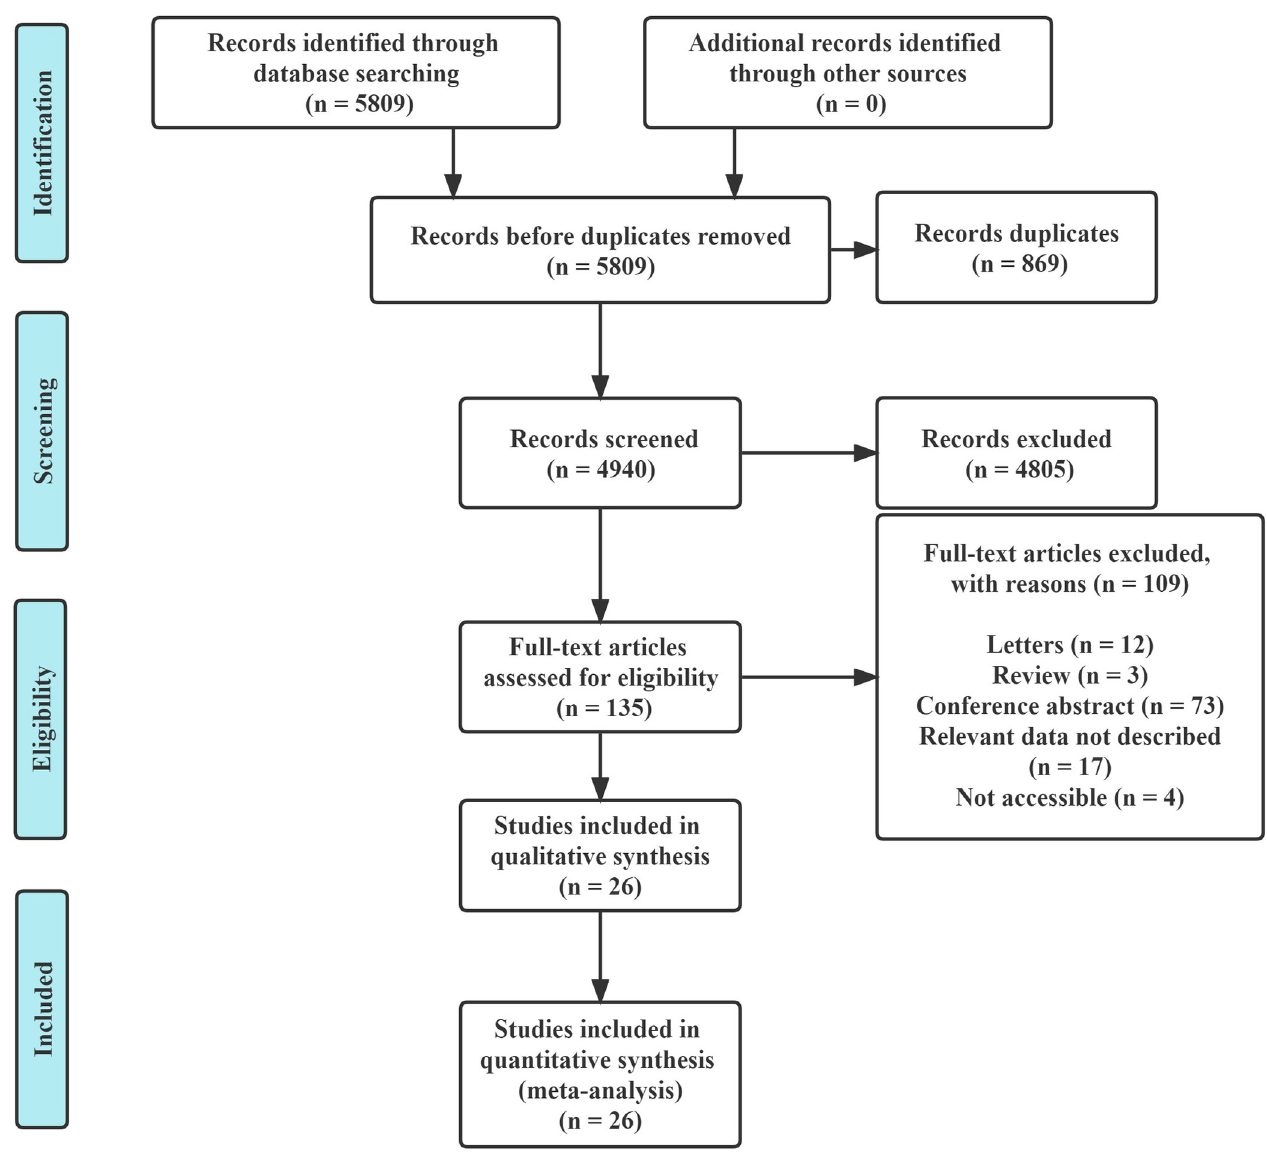
Fig 1. Flow diagram of the study selection process.